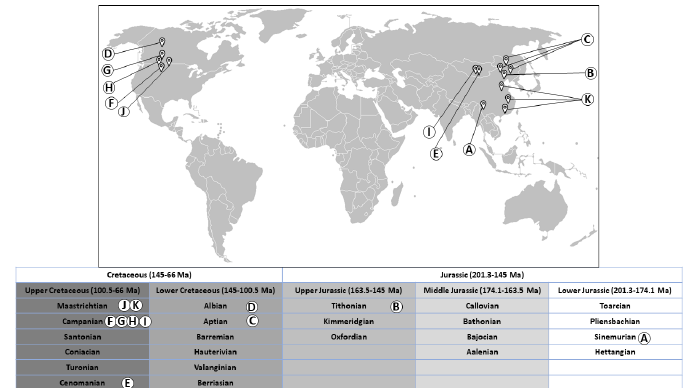
Figure 1. World map showing localities and age of dinosaurs in which organic compounds have been detected to date: ( A ) Dawa, Lufeng County, Yunnan Province, China [3]. ( B ) Yaolugao locality in Jianching County, western Liaoning Province, China [25]. ( C ) Dawangzhangzhi, Lingyuan City, Liaoning Province, China) and Sihetun, Beipiao City, Liaoning Province, China), and Yix- ian Formation, China [17,28]. ( D ) Suncor Millenium Mine, Fort McMurray, Alberta, Canada [27]. ( E ) Ukhaa Tolgod in southwestern Mongolia [24]. ( F ) Judith River Formation, eastern Montana, USA [29,30]. ( G ) Dinosaur Park Formation, Alberta, Canada [26]. ( H ) Two Medicine Formation, northern Montana, USA [31]. ( I ) Djadokhta Formation, Mongolia [23]. ( J ) Hell Creek Formation, eastern Montana, USA [18–20] ( K ) Chinese provinces (Henan, Jiangxi, and Guangdong)